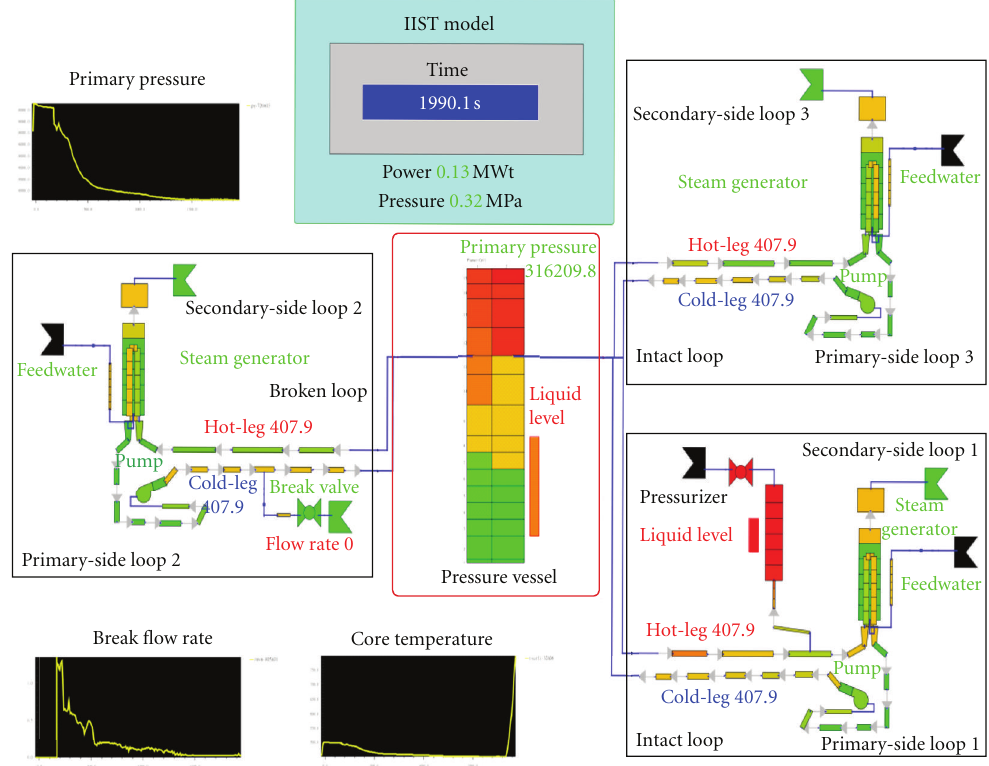
Figure 14: Animation of the IIST facility TRACE model for SBLOCA